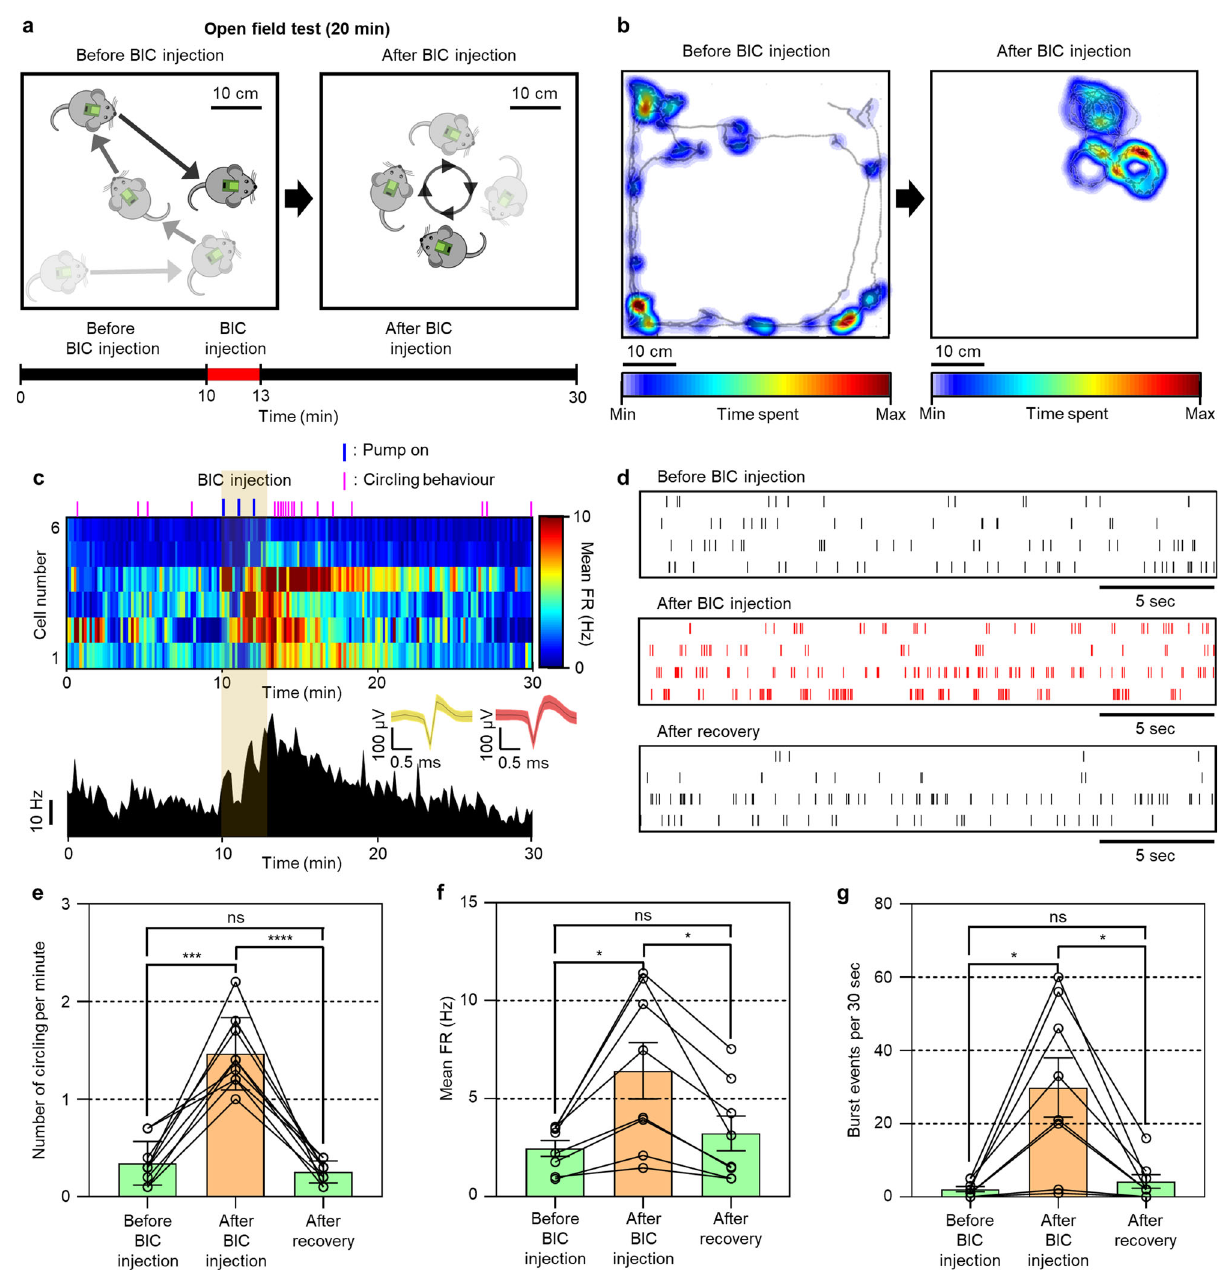
Fig. 3 | Wireless drug delivery and simultaneous monitoring of neural, beha- vioral changes. a Series of schematic illustrations showing the behavioral change induced by the injection of bicuculline (BIC) into the substantia nigra (SN) and experimental timeline. b Series of heatmaps showing the behaviors of a mouse before and after the BIC injection (5min period). c Real-time circling behavior and neuralactivitiesof SNneuronsand merged fi ringrateofSNneuronsinaccordance withBICinjection.Theblue lineabovetheheatmap indicatesthetimeatthepump on(3cycles;5sonand55soffovera60speriod).Thepinklineabovetheheatmap indicates the time at which the circling behavior appeared. The inset shows representative neural signals. d Neural fi ring patterns of SN neurons before and afterBIC injection as wellasafter recovery. “ Afterrecovery ” wasbased on the time when the compulsive circling behavior changed to normal behavior (e.g., walking